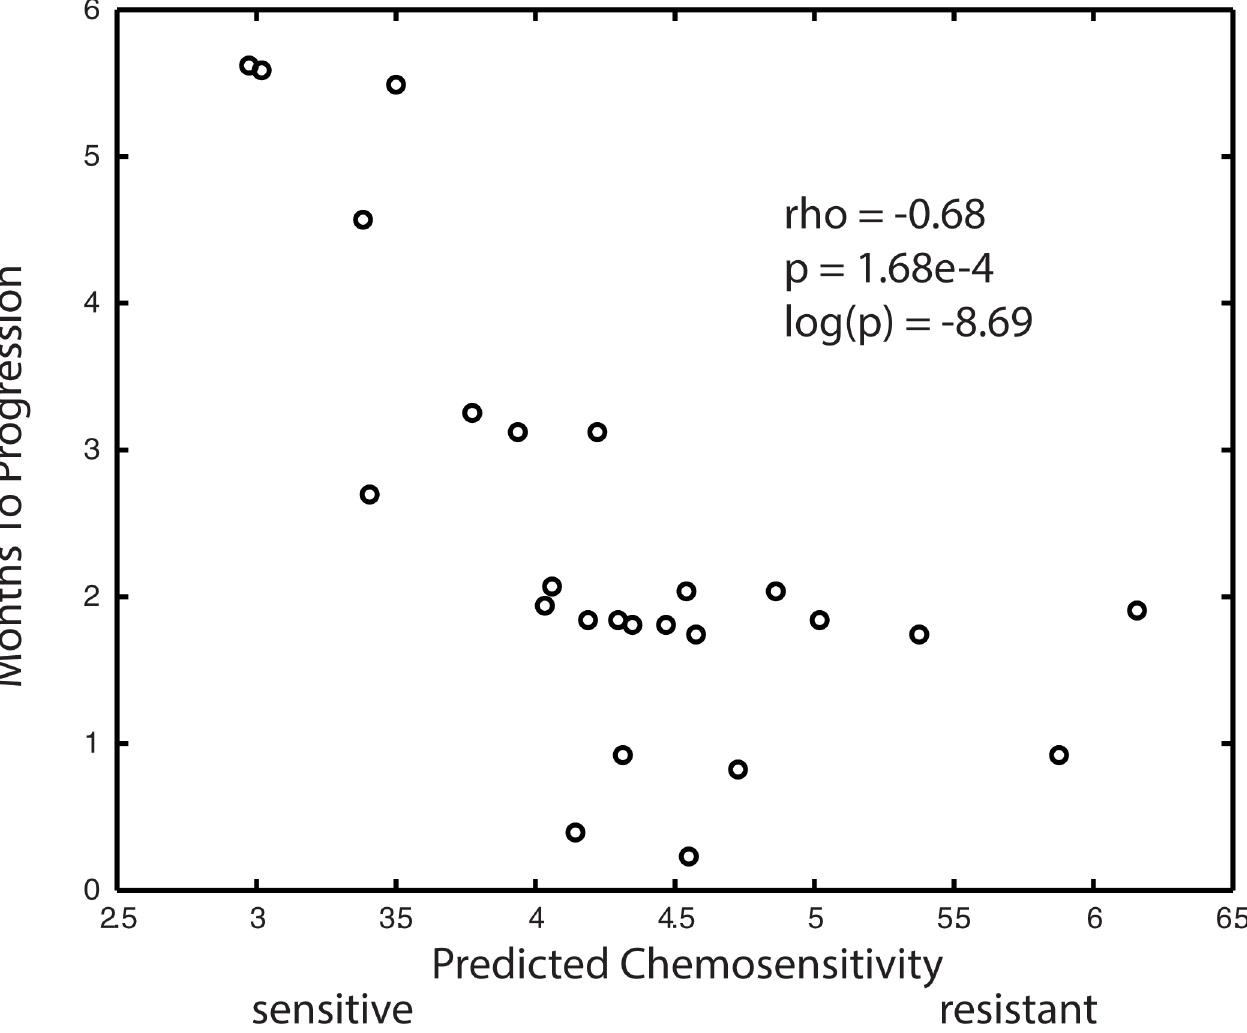
Fig 2. Plot represents the averageperformanceof the 53 linear ridge models selected by dual filtering of random simulations based on goodness of fit of the predicted preclinical erlotinib IC 50 data with model averagedgene expressions (training data), and goodness of fit to the clinical outcome of BATTLE patients receiving erlotinib (test data). X-axis representsthe model predicted chemosensitivity when using the BATTLE gene expressions in the trainingmodel. Y-axis represents the 25 patient’s observedMonths to Progression.Correlative statistics appearin the upper